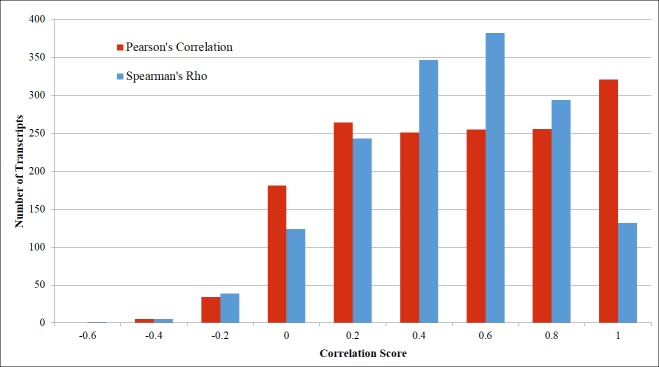
Correlation analysis between the expression patterns of the putative lncRNA transcripts and the neighboring protein coding transcripts. The Pearson’s correlation anlysis is represented by the blue bars. Spearman’s rho is represented by the orange bars. We considered a cut off for the level of correlation to be <0.6 for a lncRNA/mRNA pair that is uncorrelated